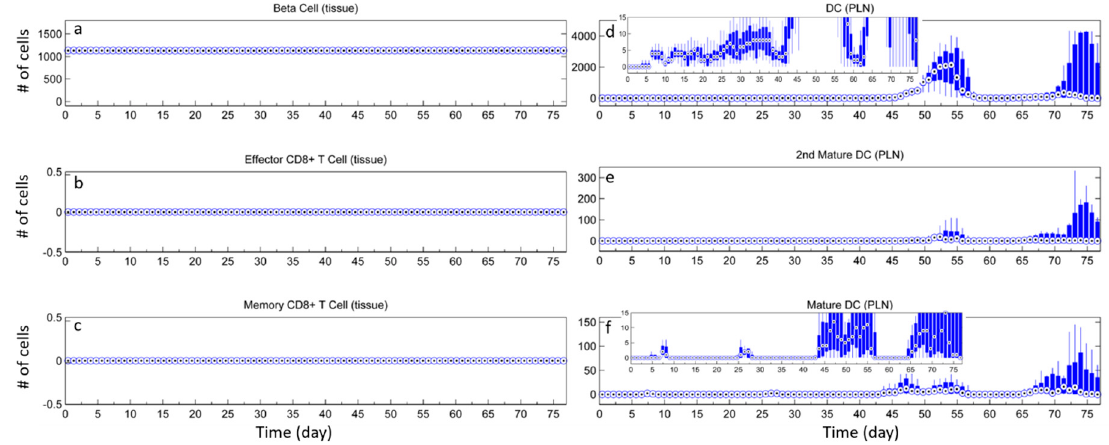
Figure A1. Simulation results for case with initial Tregs (case III). There are initial Tregs but no conversion ability of CD4 + T cells. The number of ( a ) β cells, ( b ) effector CD8 + T cells, ( c ) memory CD8 + T cells- in pancreatic tissue are shown on the left column. The number of ( d ) total DCs, ( e ) 2nd mature DCs, ( f ) mature DCs in PLN are shown on the right column. Inserts (number of cells vs. time) show small change of cell number in the bottom figures. t = 0 days correspond to 3-week age of mouse.